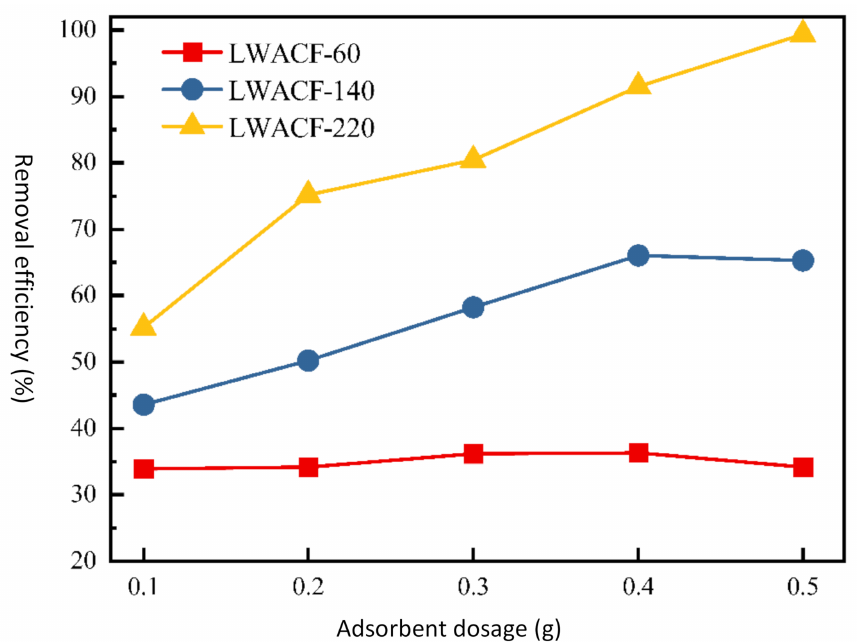
Figure 5. The removal efficiency of Cu 2+ at a constant adsorbent dose for LWACFs with different activation times at 800 ◦